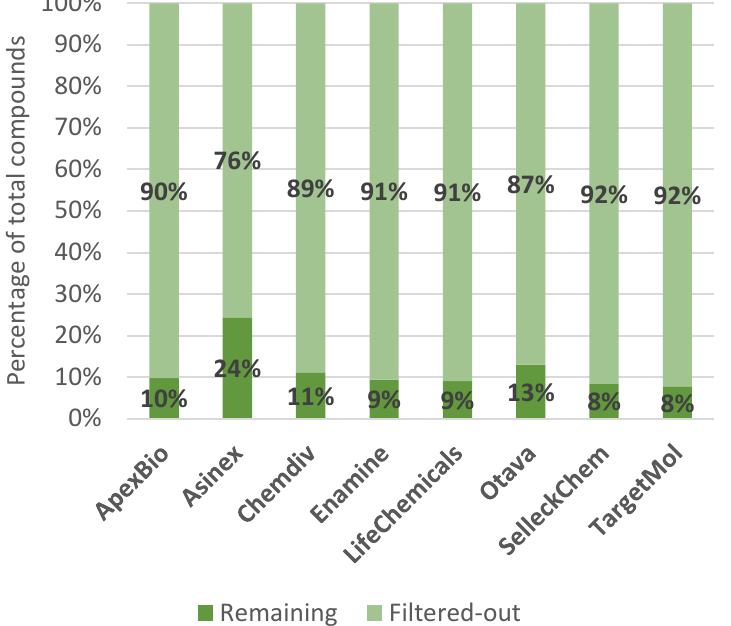
Figure 9. Compound (relative) retention after post-filtering for REOS, PAINS, Aggregators and the Lipinski rule of 5 (one rule break allowed) on protease-inhibitor-targeted libraries.